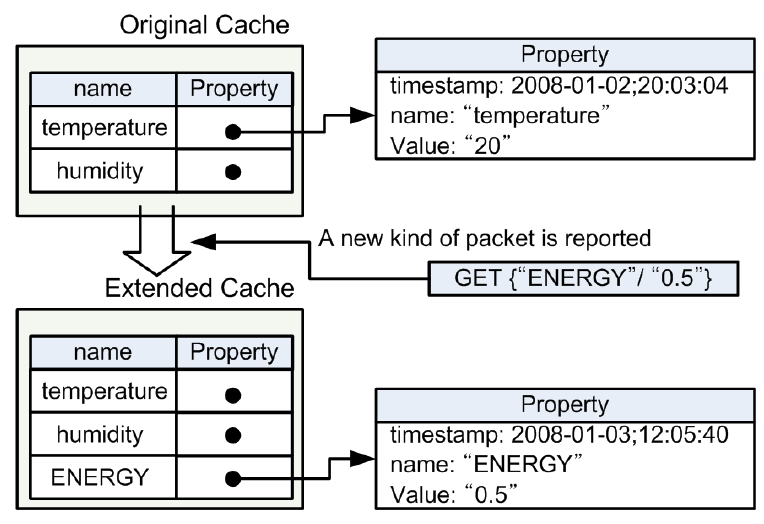
Figure 4. Cache structure of VirtualSensor